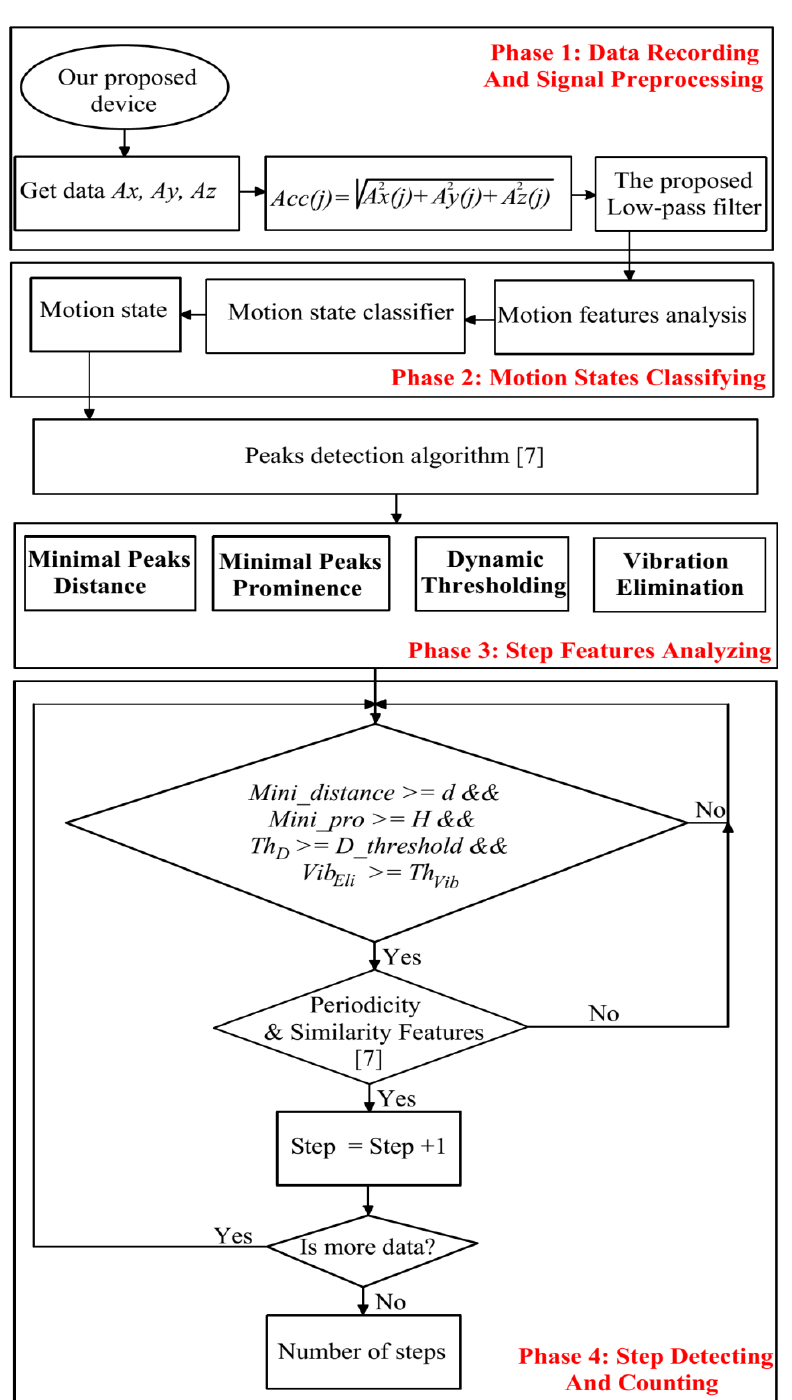
Figure 1. The flowchart depicting our step counting method.